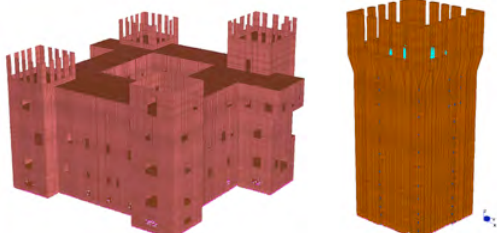
Figure 5. (a) FE model of San Giorgio Castle and (b) of the North East Tower